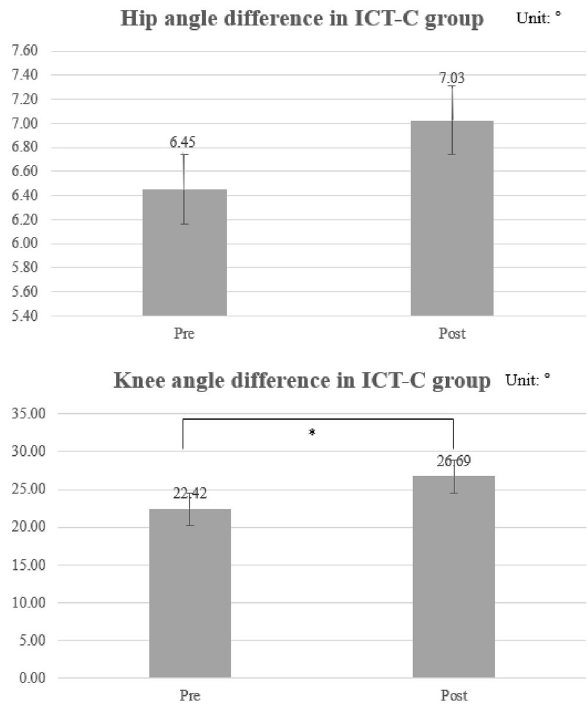
Figure 4. Paretic hip and knee angle kinematics in ICT-C group (unit: degree). ICT-C ankle–knee–hip interlimb coordinated humanoid robot combined with conventional physical therapy; *Denotes significance at P < 0.05; Number, mean; Bar, standard deviation.